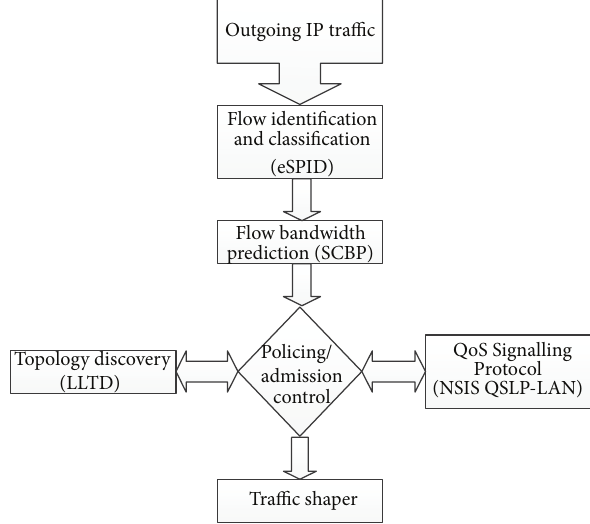
Figure 1: Overview of the QoSiLAN key